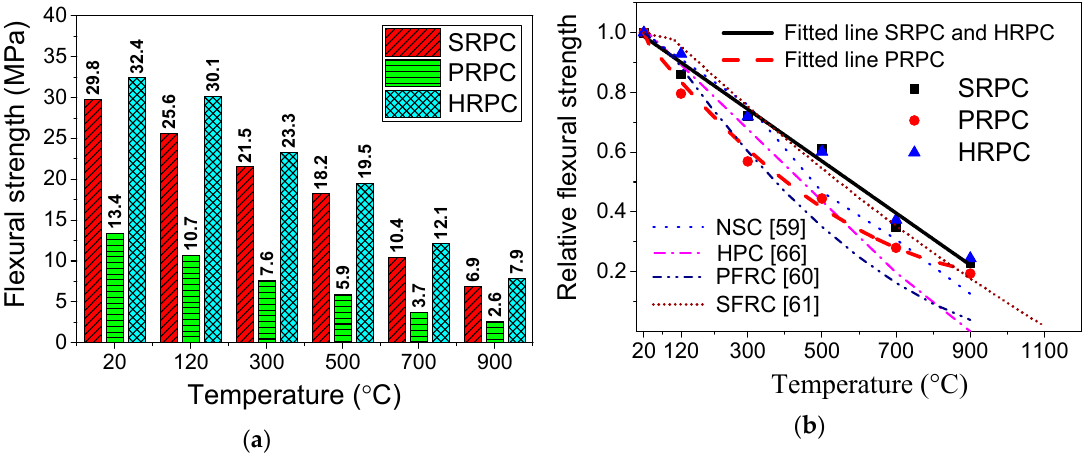
Figure 7. Flexural strength of RPC: ( a ) Absolute values and ( b ) comparison with earlier